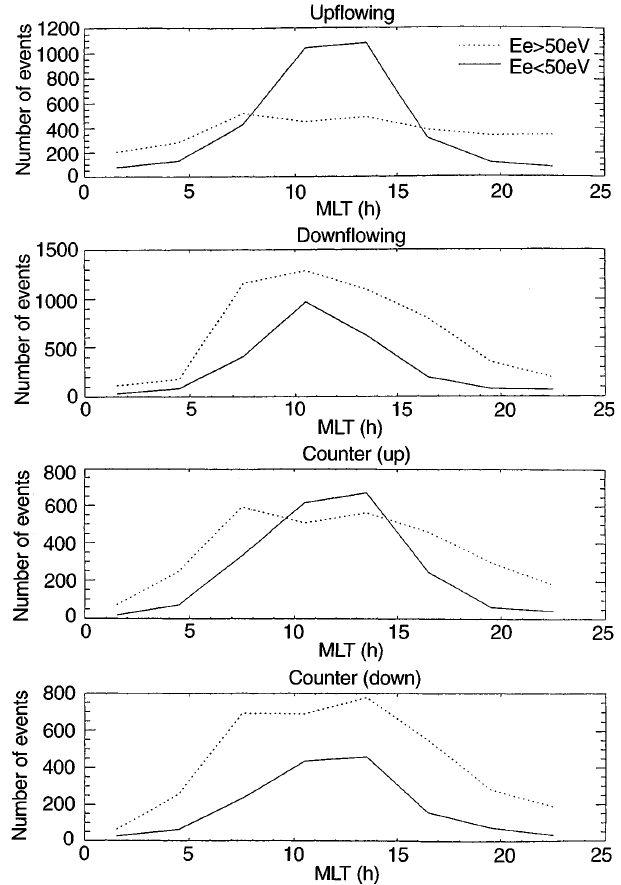
Fig. 4. MLT distribution of the four types of field-aligned electron beam. The electron beams are divided into two by their energy ( Ee )